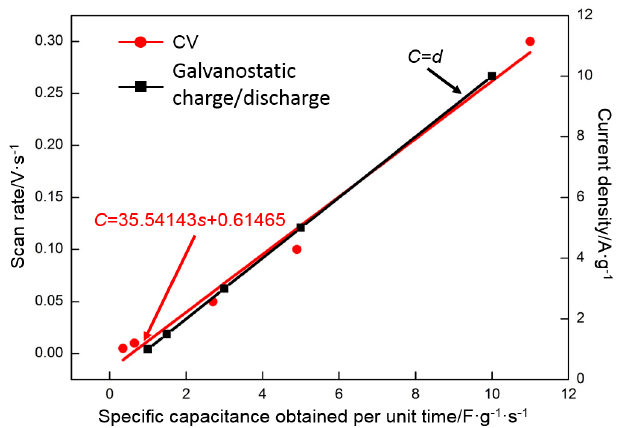
Figure 16. Specific capacitance of RGO obtained per unit time as a function of the scan rate and current density.